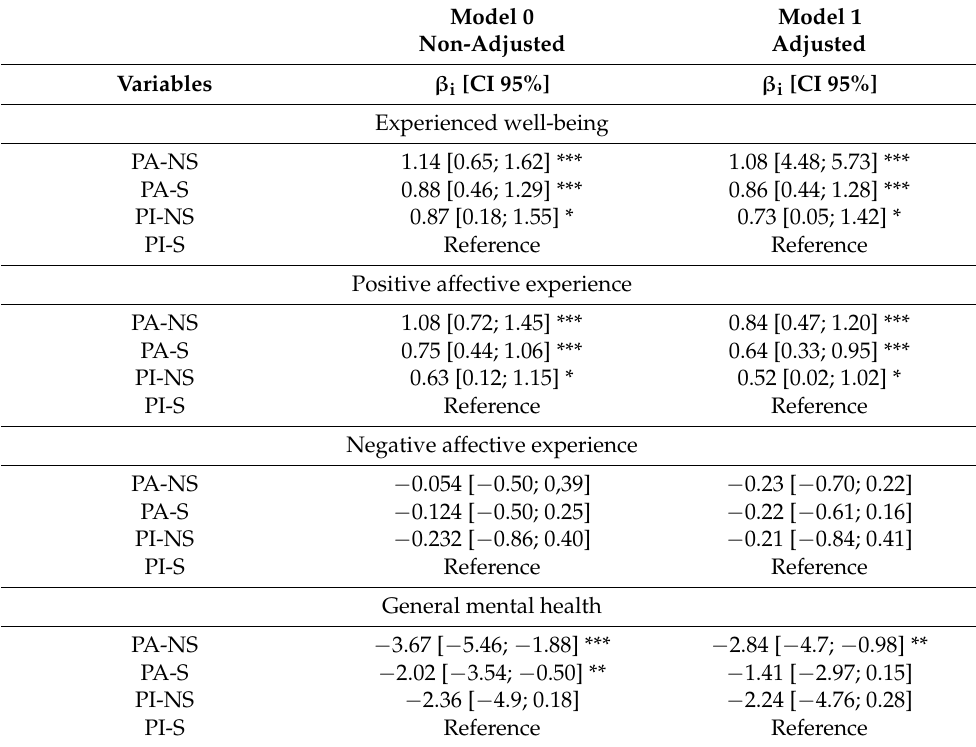
Table 2. Estimated effect of physical activity behavioral profile and sedentary